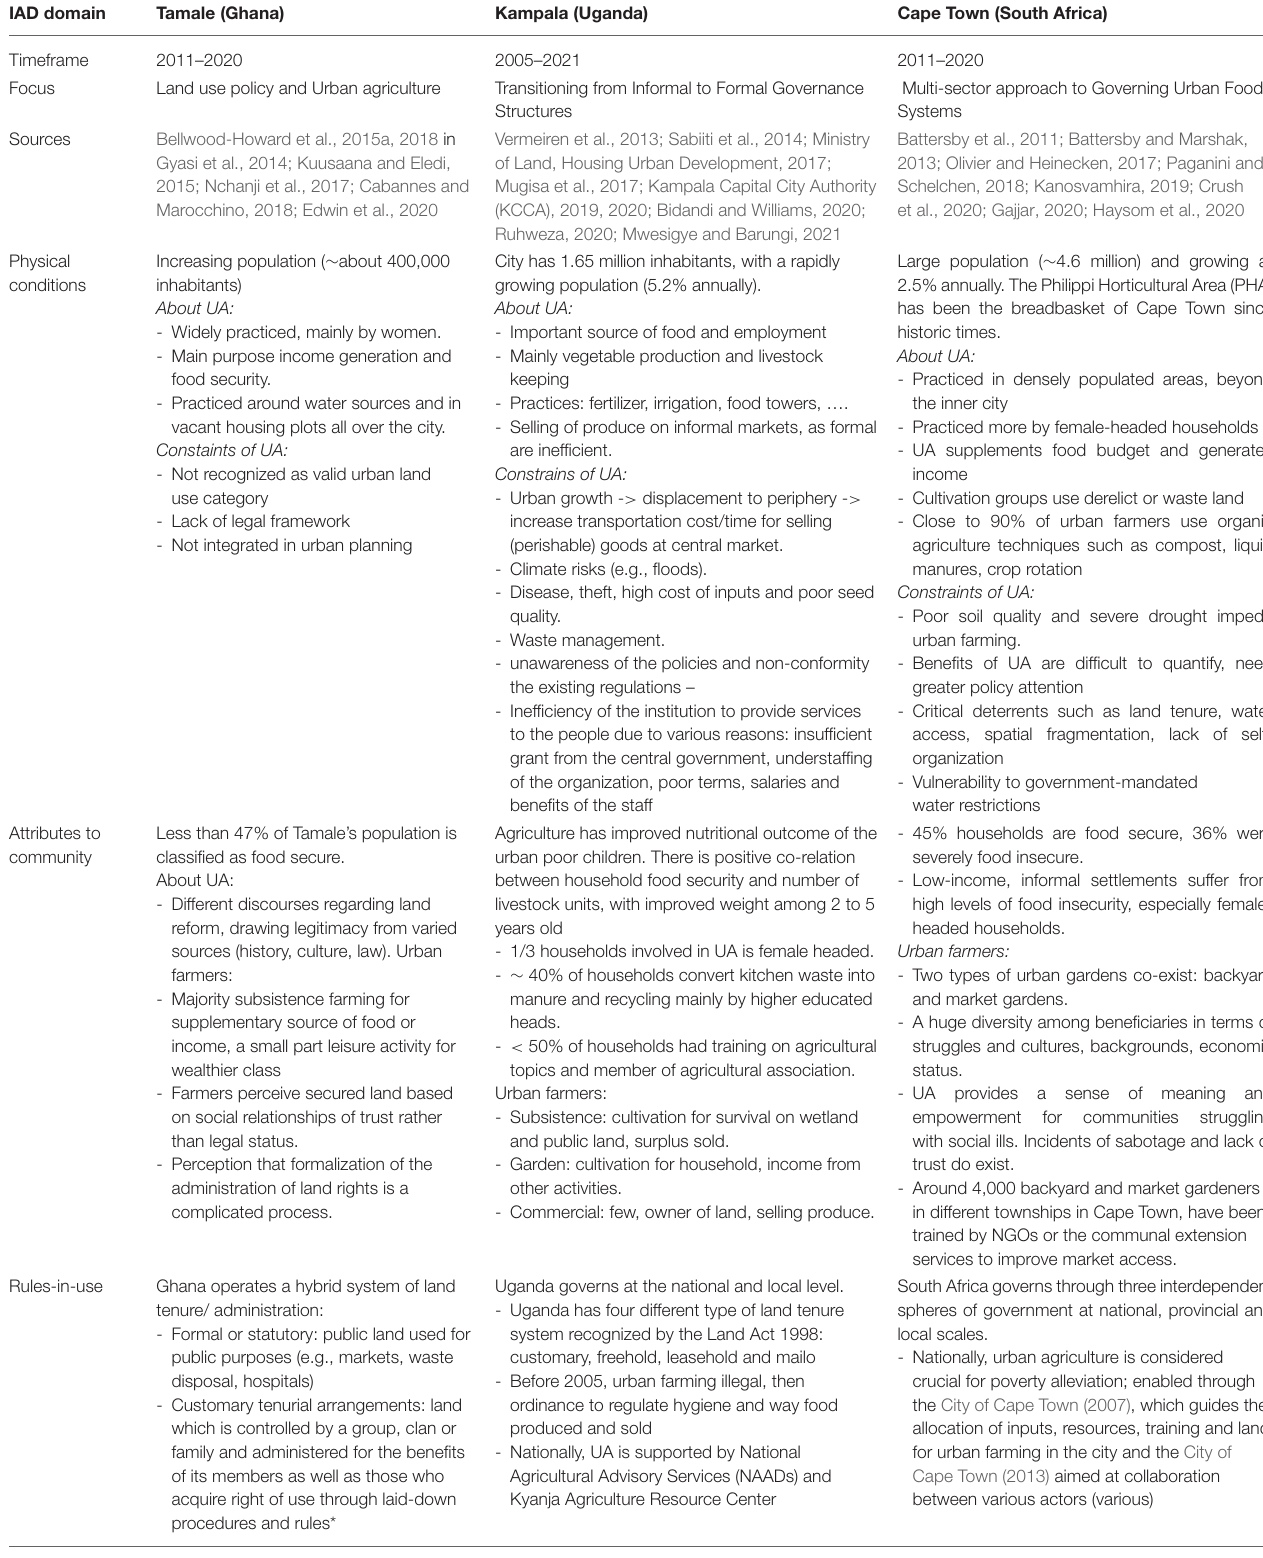
TABLE 1 | Results of the analysis of the three case studies; i.e., Tamale, Kampala and Cape Town, using the IAD framework for policy analysis (Ostrom, 2005). IAD